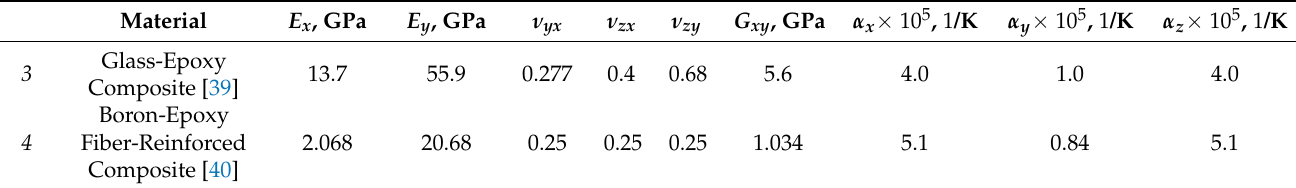
Table 2. Elastic and thermoelastic material moduli of some orthotropic